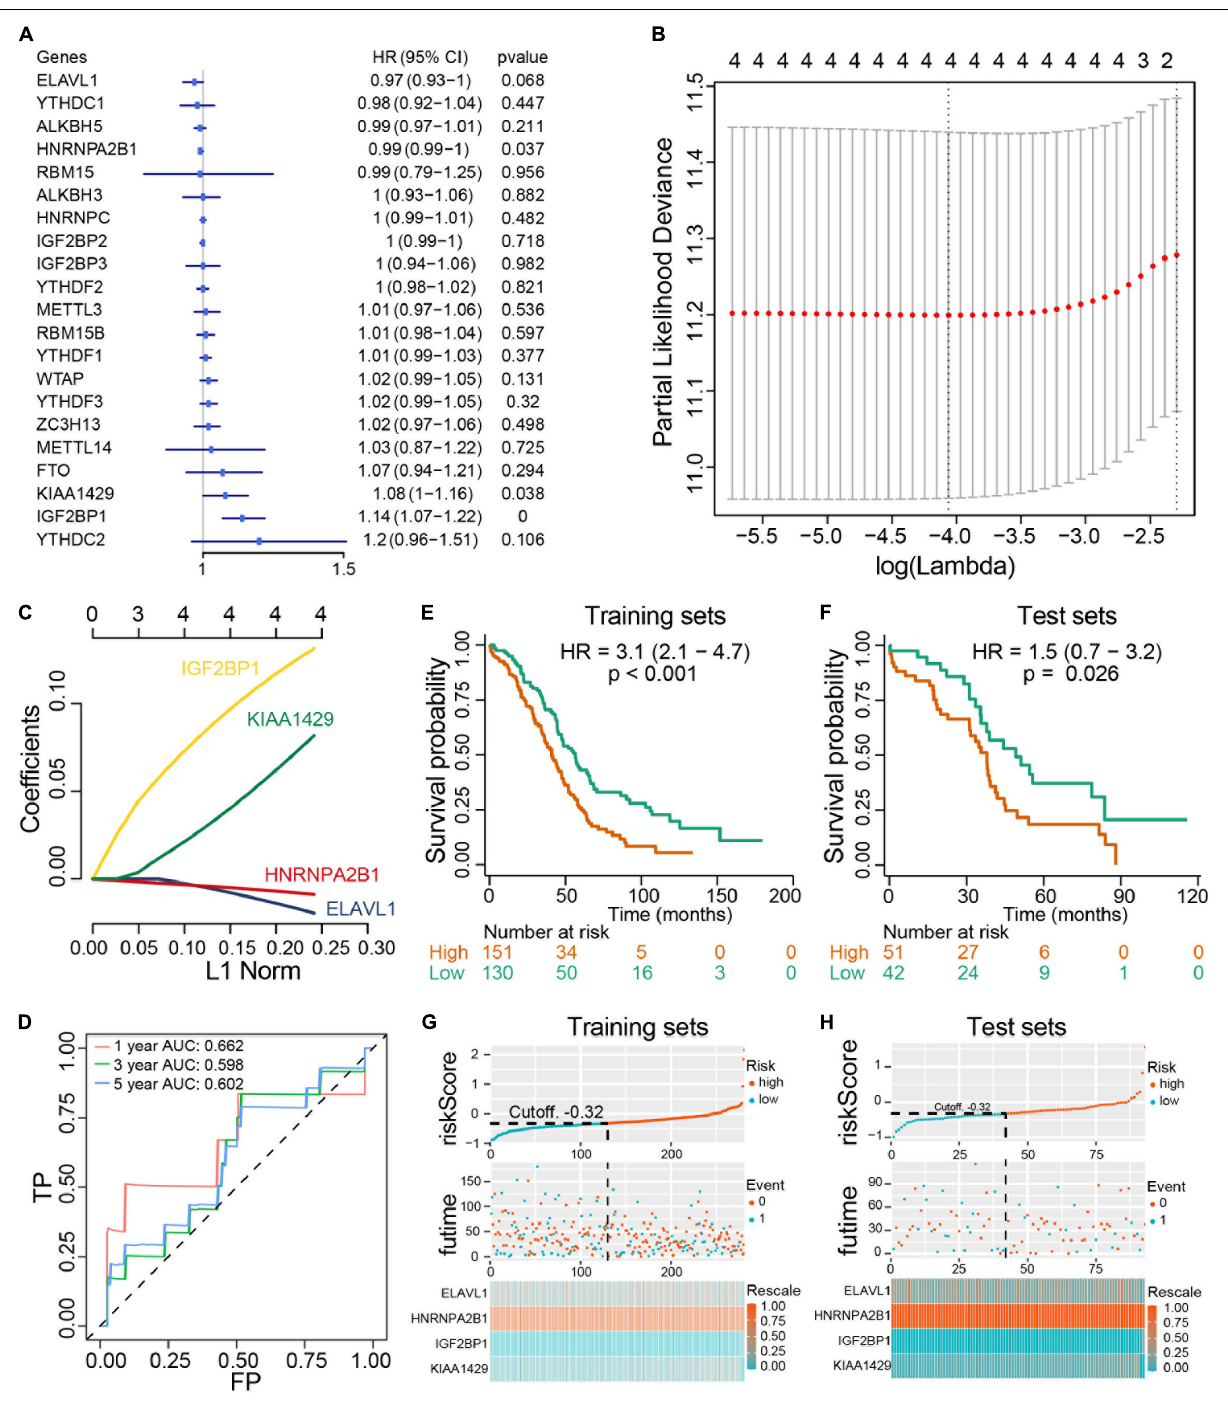
FIGURE 6 | Construction and evaluation of prognostic risk signature with four m 6 A RNA methylation regulators in ovarian cancer cohorts. (A) Univariate Cox regression analysis results show the p values and hazard ratios (Liu et al.) with confidence intervals (CI) of the 14 differentially expressed m 6 A RNA methylation regulatory genes. (B,C) LASSO Cox regression analysis results show the identification of the 4 prognostic risk signature genes, and the risk score model is: risk score = 0.12218 × IGF2BP1 + 0.0687 × KIAA1429 - 0.0158 × ELAVL1 - 0.00763 × HNRNPA2B1. (D) The ROC curve for evaluating the prediction efficiency of the prognostic signature. (E,F) The survival analysis of training set and test set. Both two set were divided by the cutoff value according risk score calculated by LASSO multivariate Cox model. (G,H) The distributions of prognostic signature-based risk scores and its corresponding expression profiles in the training set and test set. The red dots represent high-risk patients and green dots represent low-risk